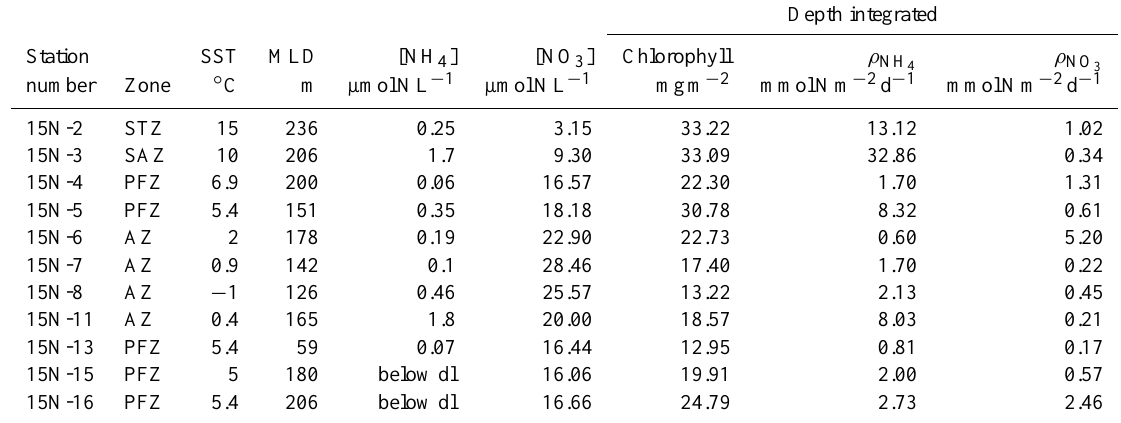
and associated SST, MLD (mixed layer depth), [NO 3 ], [NH 4 ]. [NO 3 ] and [NH 4 ] are given Table 1. Winter depth-integrated ρ NH , and ρ NO 4 3 for the 55% light depth only. The detection limit (dl) for [NH 4 ] was 0.03µmolL − 1 . The zones are the frontal zones defined by the criteria of Orsi et al. (1995). STZ represents the subtropical zone, SAZ the subantarctic zone, PFZ the polar frontal zone and AZ the Antarctic zone.